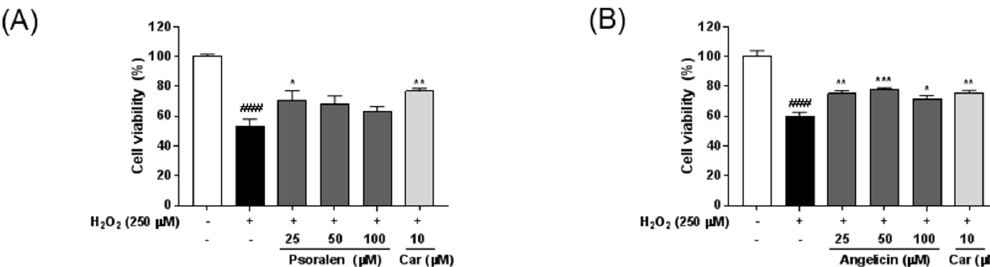
Figure 4. Figure 4. Cont.